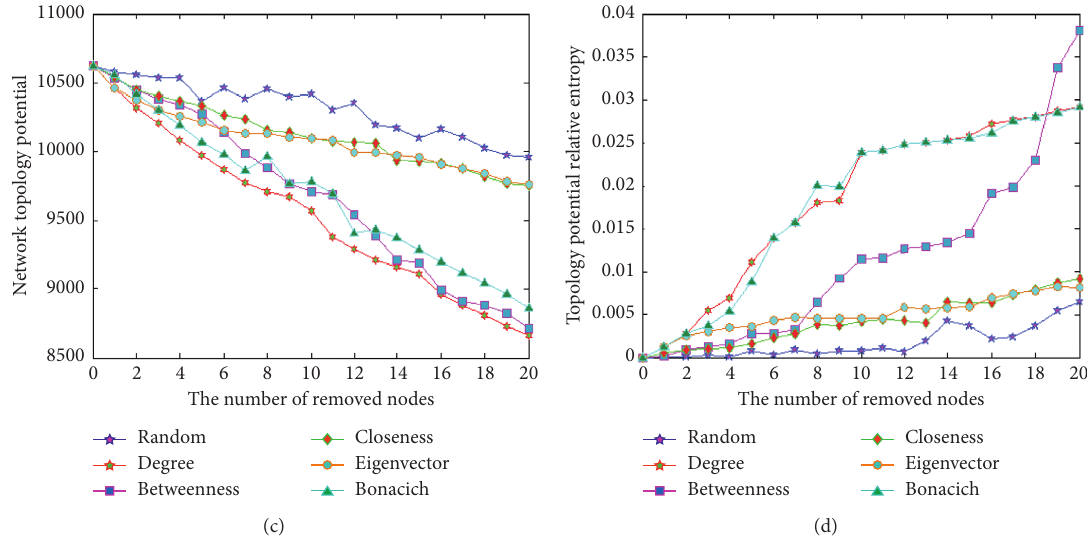
Figure 8: Comparison of robustness measures for different attacks on ARRN, and the top-20 nodes are removed by the order of descending metric